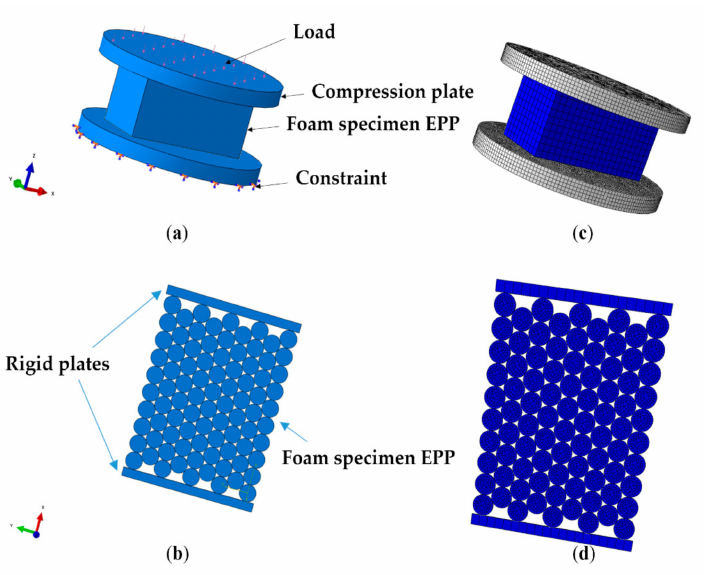
Figure 9. Uniaxial compression EPP specimen ( a ) CAD model ( b ) structure small beads: section view of CAD model; ( c ) finite element model of specimen; ( d ) structure small beads: section view of Finite element